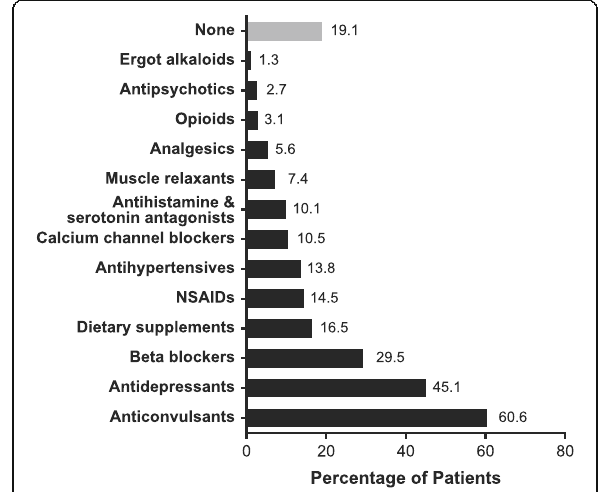
Fig. 3 Oral preventive treatments* currently or previously used by